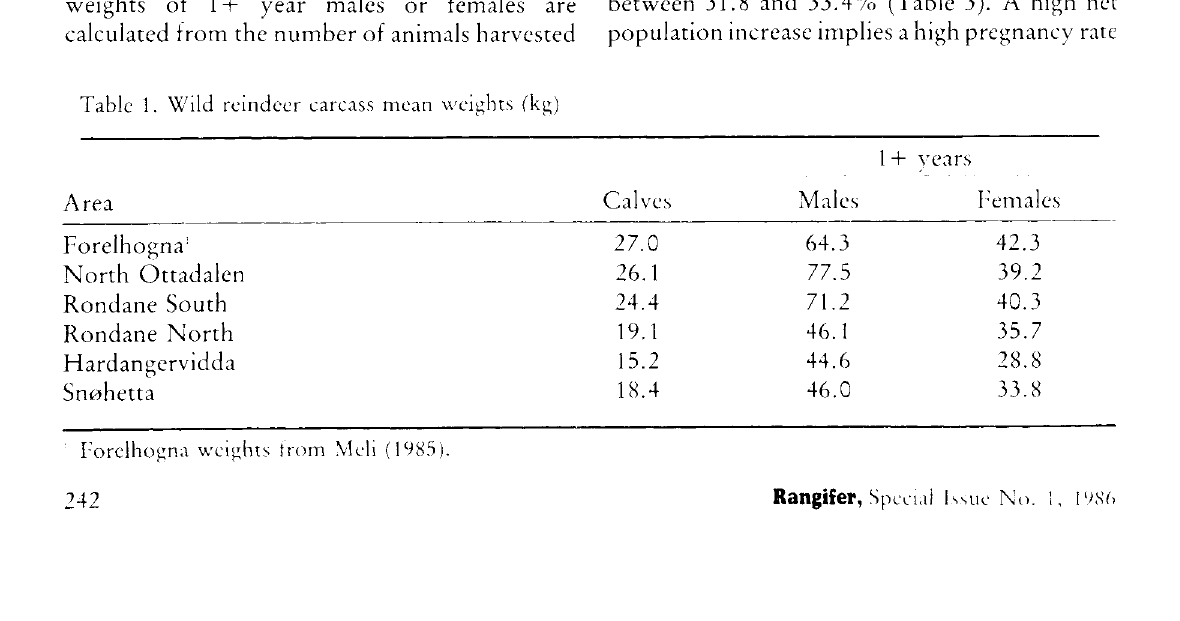
Table 1. Wild reindeer carcass mean weights